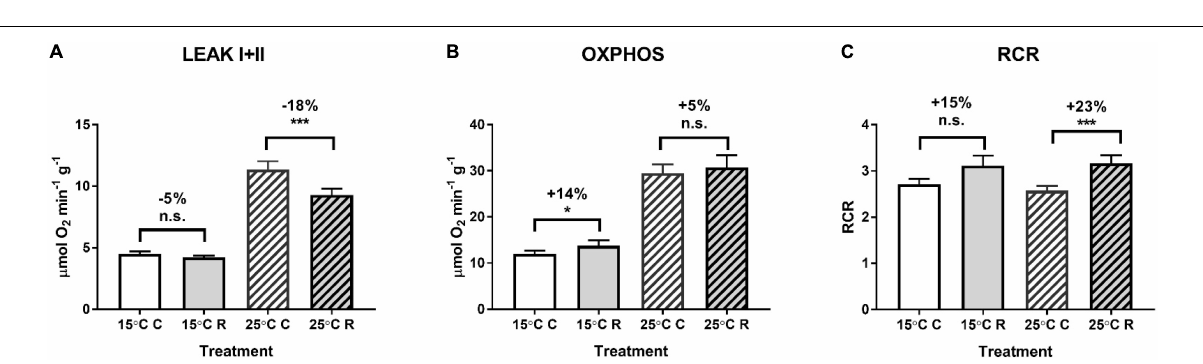
after the H/R stress including kynurenine/ α -aminoadipate aminotransferase (7.1-fold increase), propionyl-CoA carboxylase β chain (4.9-fold), cytochrome c oxidase assembly protein (3.8-fold), Golgi phosphoprotein 3 (2.9-fold), Bax inhibitor